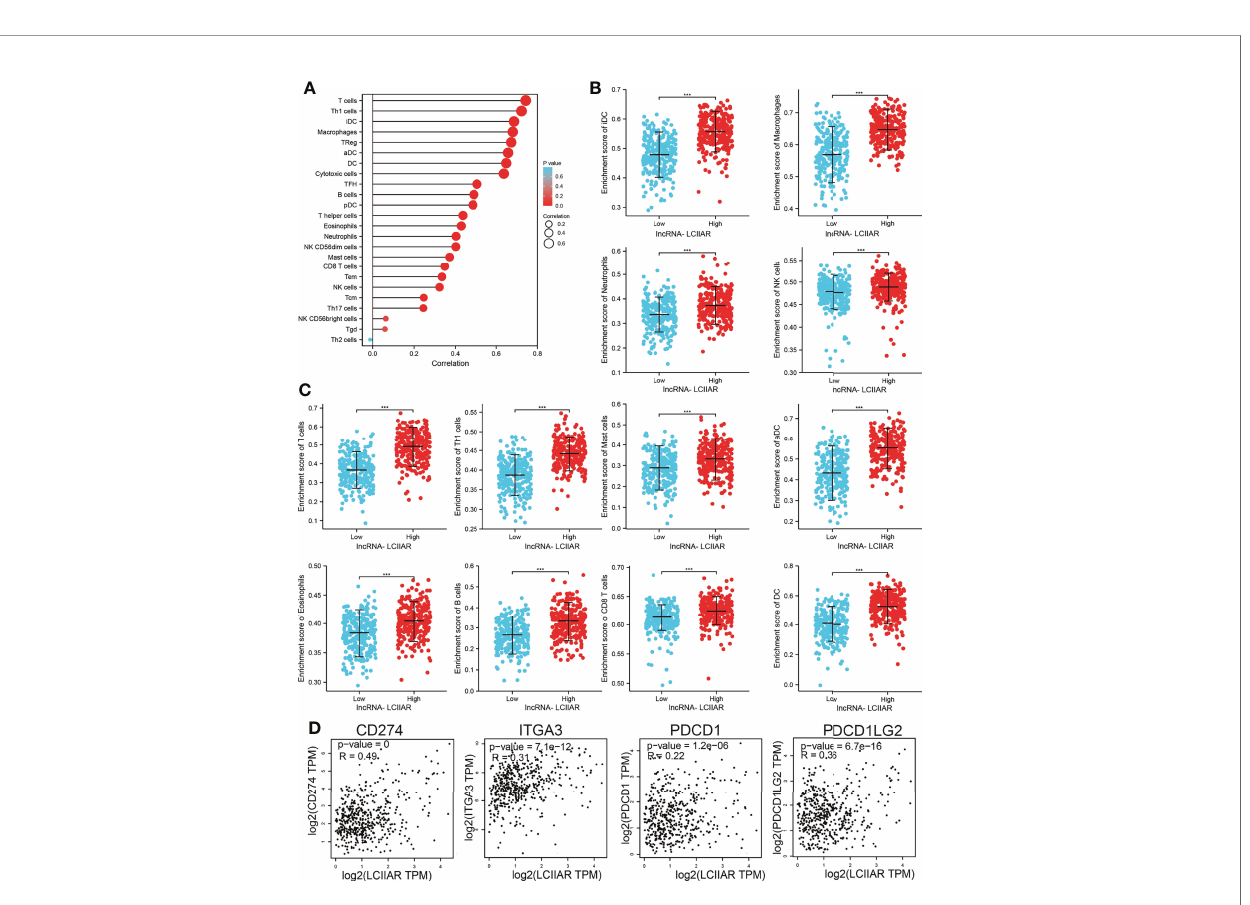
FIGURE 7 | Correlation between LCIIAR expression and immune cell in fi ltration (A – C) Correlation between LCIIAR expression and various immune cell in fi ltration in LUAD. (D) Correlation between LCIIAR expression and check point-related gene in LUAD. ***p <